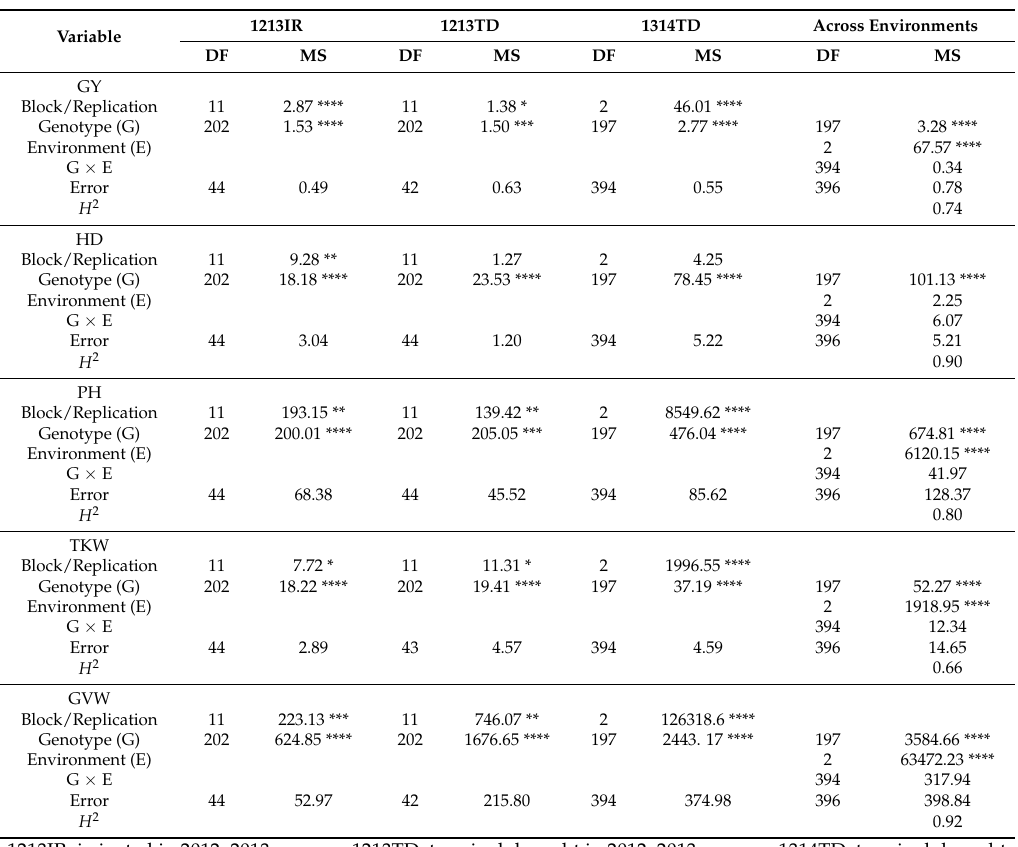
Table 1. The analysis of variance (ANOVA) and broad-sense heritability ( H 2 ) of winter accessions (198 accessions and five checks in 1213IR and 1213TD, three replications in 1314TD) for the traits in three